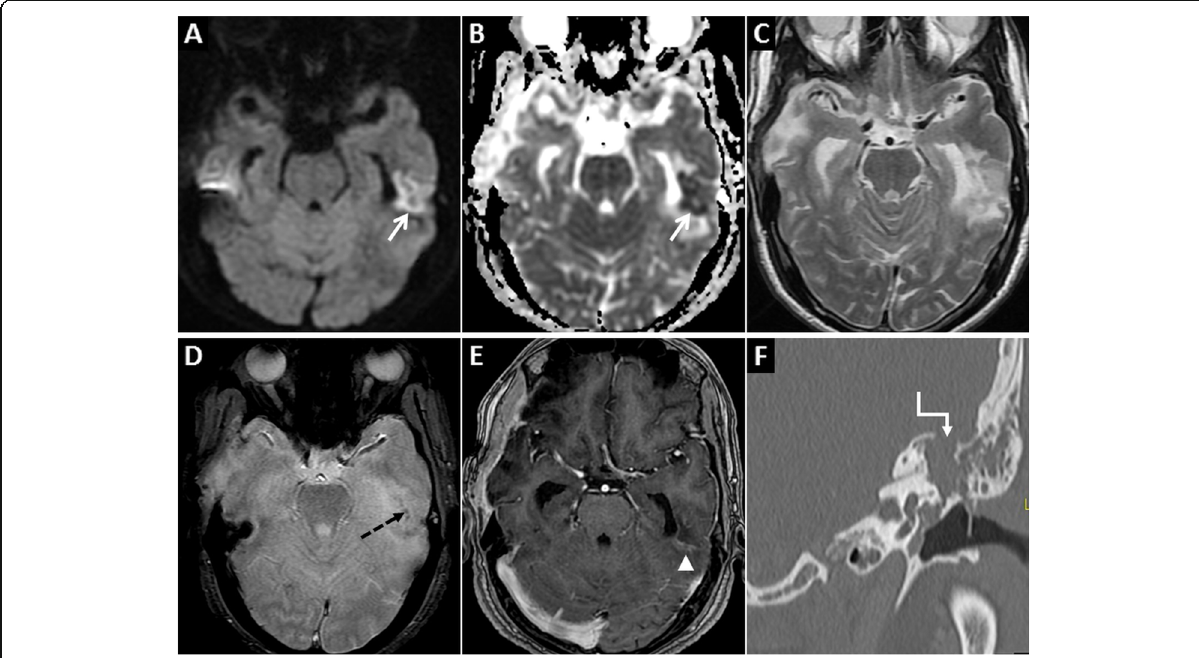
Fig. 7 Pre and post-contrast MRI of the brain in a 70-year-old male patient who presented with altered mental status and discharging left ear. Localised GRD is seen in the posterior part of the left inferior temporal gyrus (arrows) on axial DWI ( a ) and ADC image ( b ) along with surrounding vasogenic oedema on axial T2W image ( c ). There are tiny haemorrhages (dashed arrow) in this lesion on axial GRE image ( d ) and subtle gyriform enhancement (arrowhead) on post-contrast axial T1W image ( e ). Coronal reconstruction of subsequent high-resolution CT of the left temporal bone ( f ) reveals extensive left otomastoiditis with a large bony defect in the left tegmen tympani (stepped arrow). Imaging findings are in keeping with complicated left otomastoiditis leading to